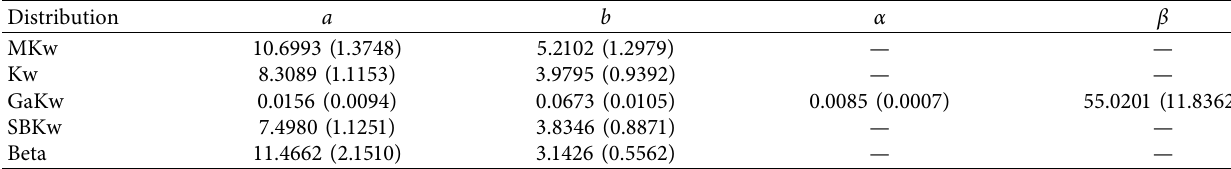
Table 11: MLEs and their standard errors (in parentheses) for data set 5.